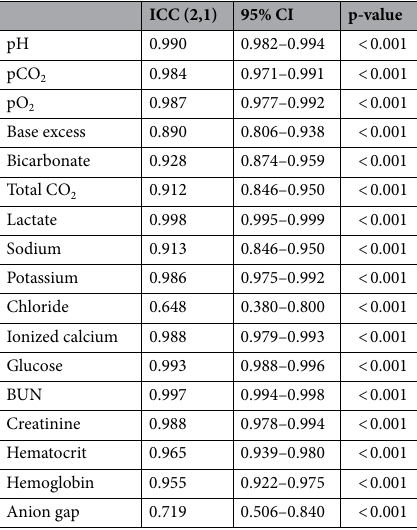
Table 1. Intraclass correlation coefficient (ICC) results comparing the control and experimental groups. Most results show ICC values higher than 0.9 with statistically significant p-values. The ICC model was a two-way random effect and single-measure model with absolute agreement. ICC intra-class correlation coefficient, pCO 2 partial pressure of carbon dioxide, pO 2 partial pressure of oxygen, CI confidence interval, BUN blood urea nitrogen.